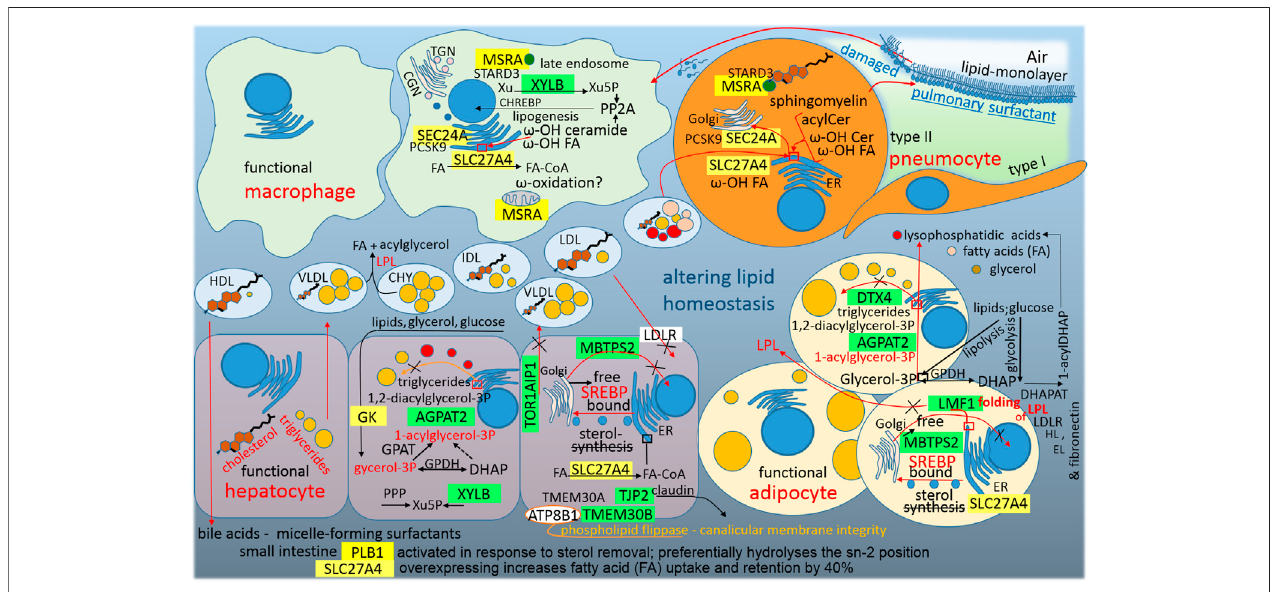
FIGURE 7 | A graphic illustration of “ Altering lipid homeostasis as a consequence of SARS-CoV-2 infection. ” Green highlights show the alignments with the complement sequence (post-transcriptionally repressed); yellow highlights show the alignments with the reverse complement sequence (post-transcriptionally promoted). The functions of the identi fi ed genes/proteins by the methodology are summarized in Supplementary Table S1